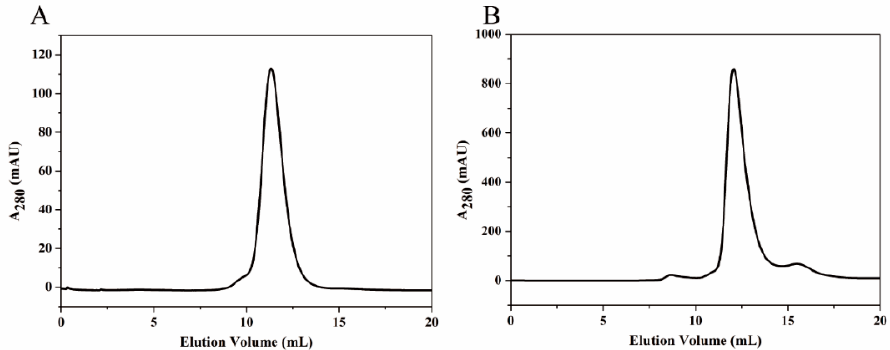
Figure 2. Size exclusion chromatography (SEC) of HE ( A ) and KG ( B ). Elution was monitored at 280 nm.